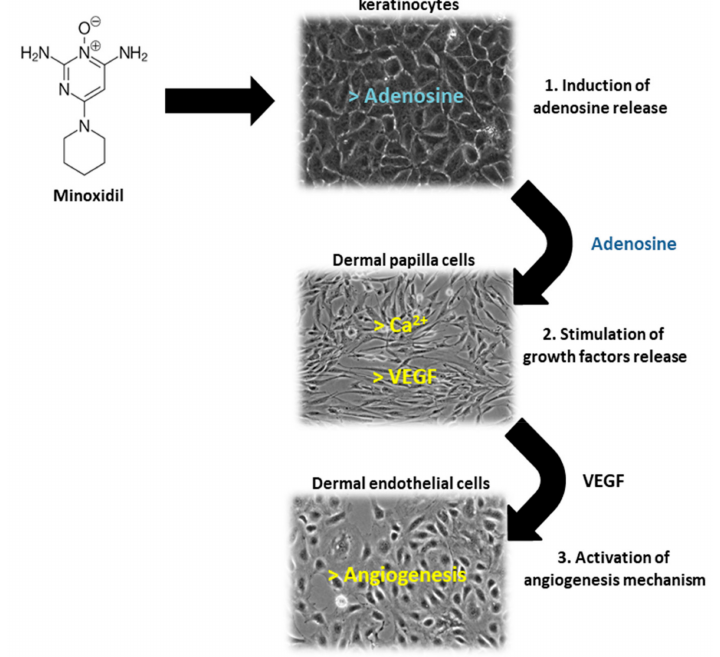
Figure 3. Schematic representation of Minoxidil (MXD) action on di ff erent cells of HF: keratinocytes, dermal papilla cells and dermal microvascular endothelial cells. (1) MXD induces the release of adenosine by follicle keratinocytes, (2) adenosine stimulates the release of growth factors (VEGF) by follicle dermal papilla cells (FDPC), (3) VEGF promotes angiogenesis mechanism in dermal microvascular endothelial